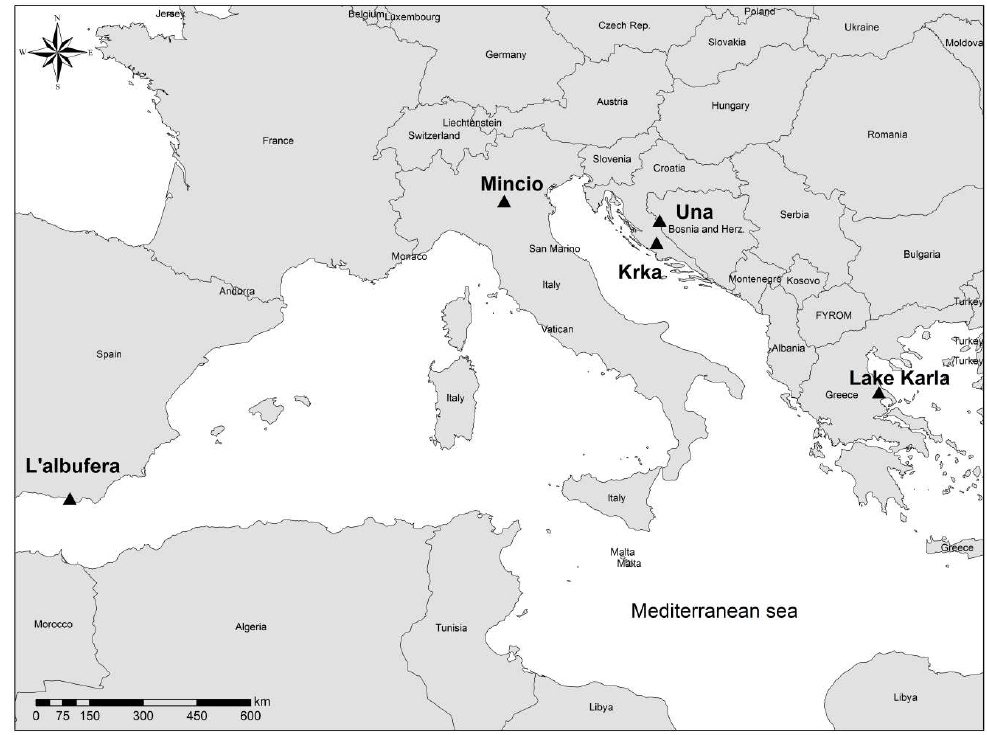
Figure 1. The five study-area national parks’ locations.